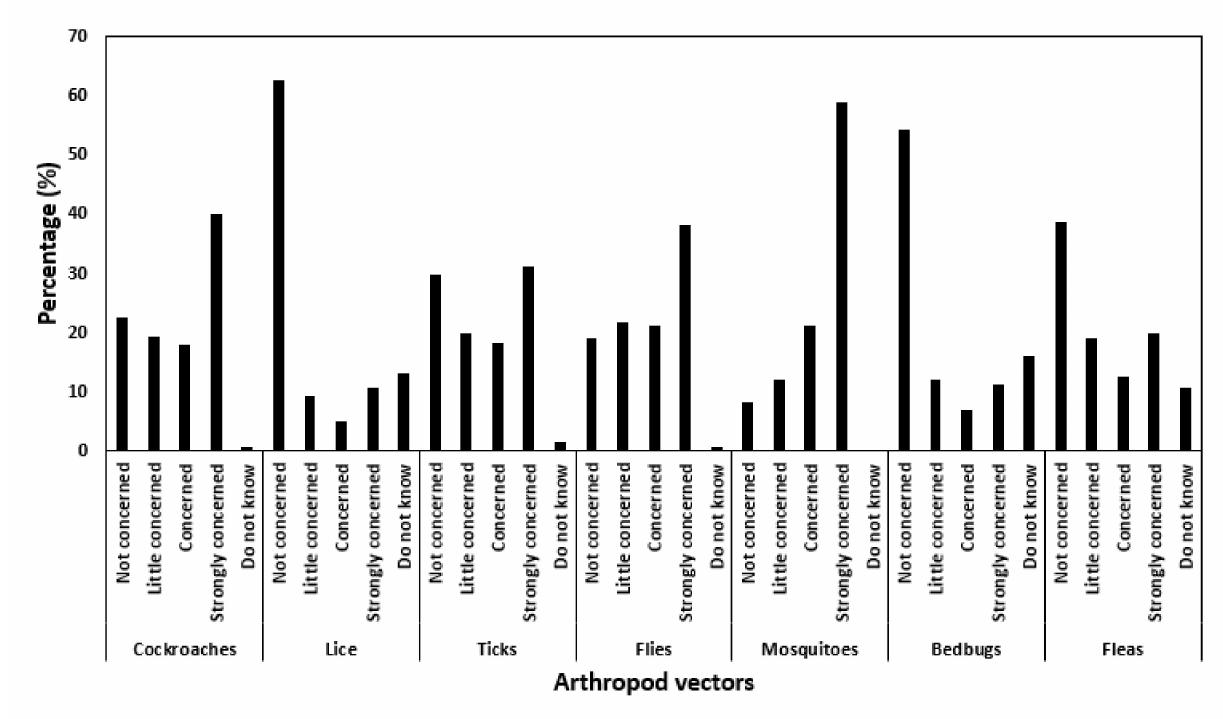
Figure 3. Summary of respondents’ perceptions (%) on vector arthropods rated as; not concerned, little concerned, concerned, strongly concerned, and did not